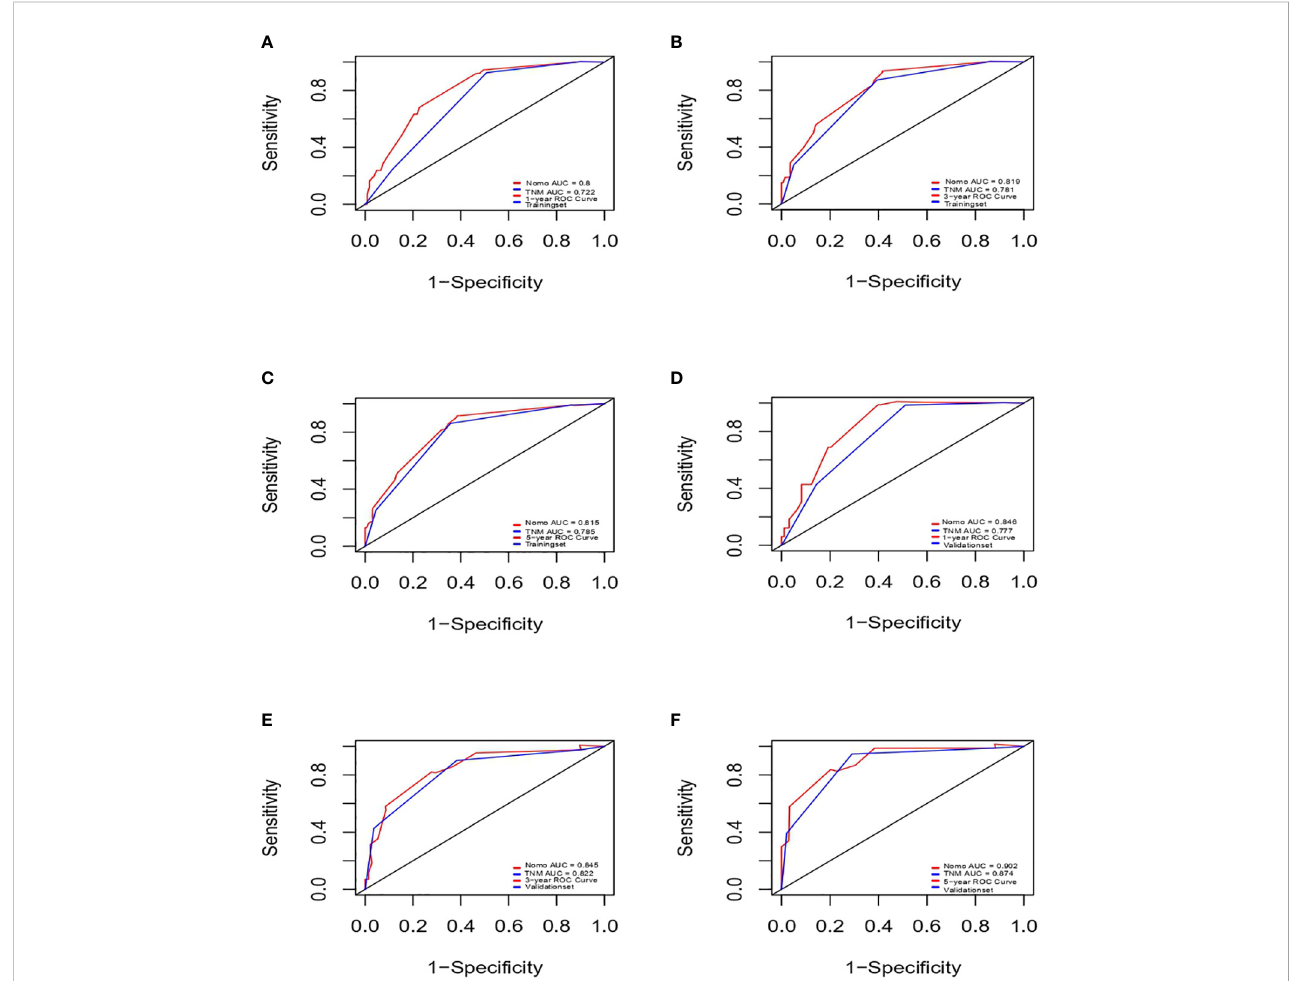
FIGURE 3 ROCs of IGBC for predicting OS at 1-, 3-, 5-year in the training (A – C) and validation set (D – F) , respectively. ROC, receiver operating characteristic; AUC, area under the curve; IGBC, incidentally gallbladder cancer; OS, overall